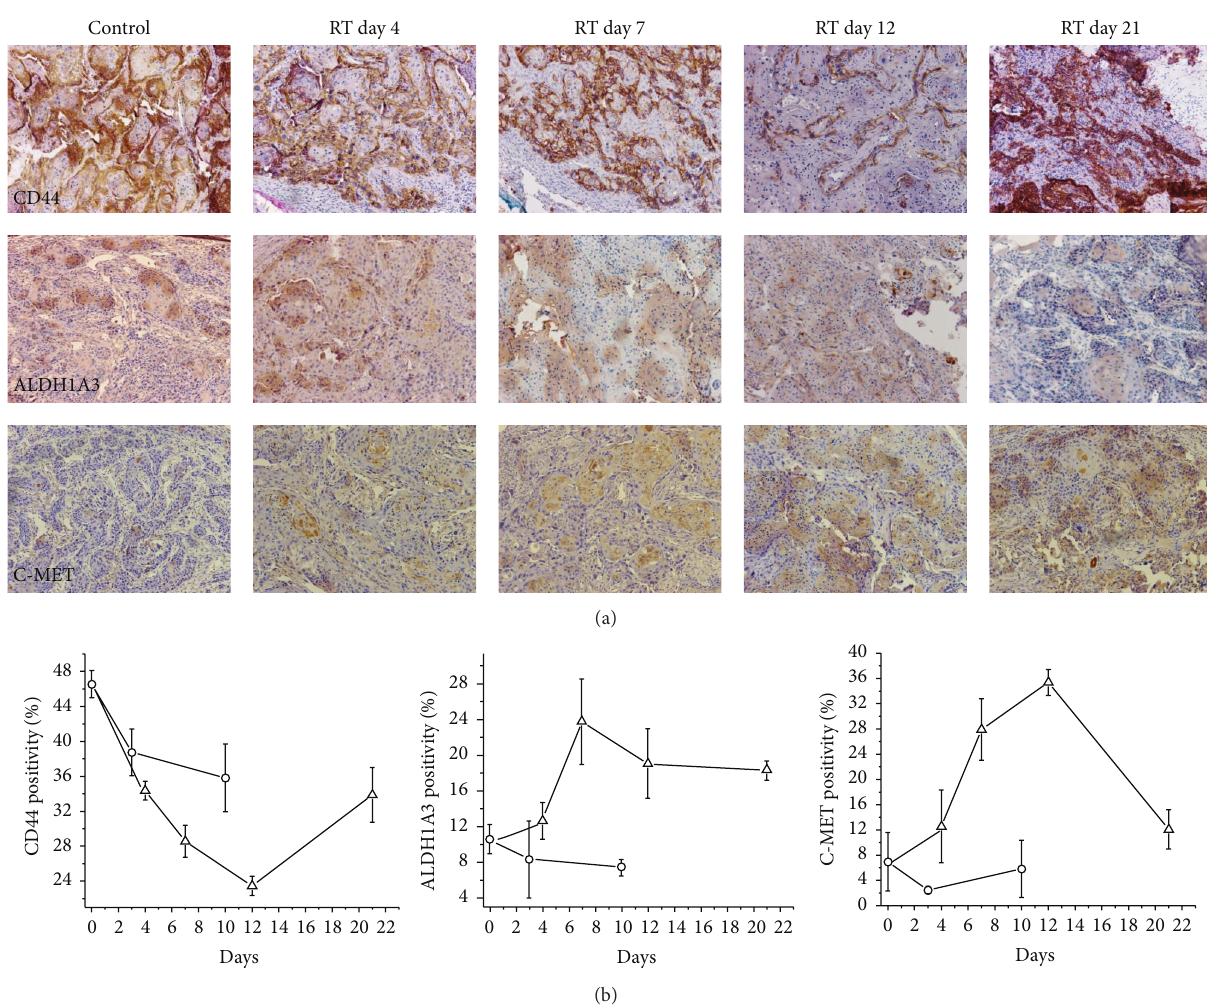
Figure 2: Immunohistochemical staining for CD44, ALDH1A3, and c-MET (a) and image analysis quantification of protein expression (b) after radiation (RT) treatment. CD44 was mainly associated with the cell surface and tended to stain cells in the outer layers of the tumor islands; its expression decreased after radiation but recovered between days 12 and 21. ALDH1A3 staining was cytoplasmic and showed a diffuse pattern throughout the tumors. After irradiation ALDH1A3 increased to a maximum on day 7 and remained elevated for the period of observation. In some areas cells became more intensely stained with ALDH1A3 after irradiation. c-MET showed a staining pattern which was similar to ALDH1A3 being diffuse and cytoplasmic. The levels of c-MET increased at day 4 and reached a maximum at day 12 after which they declined rapidly to control levels ( ×